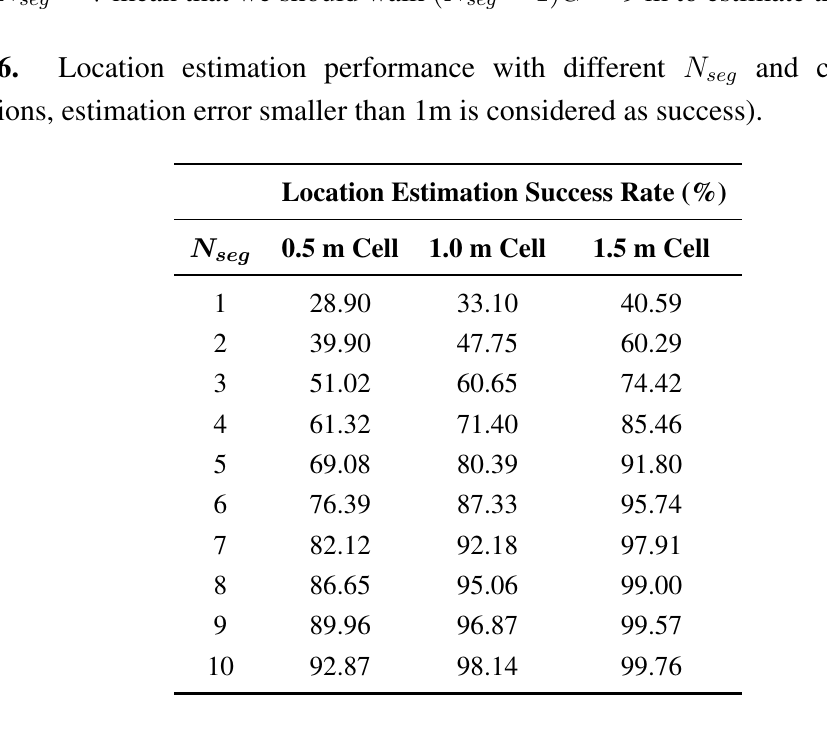
and cell sizes (100 seg